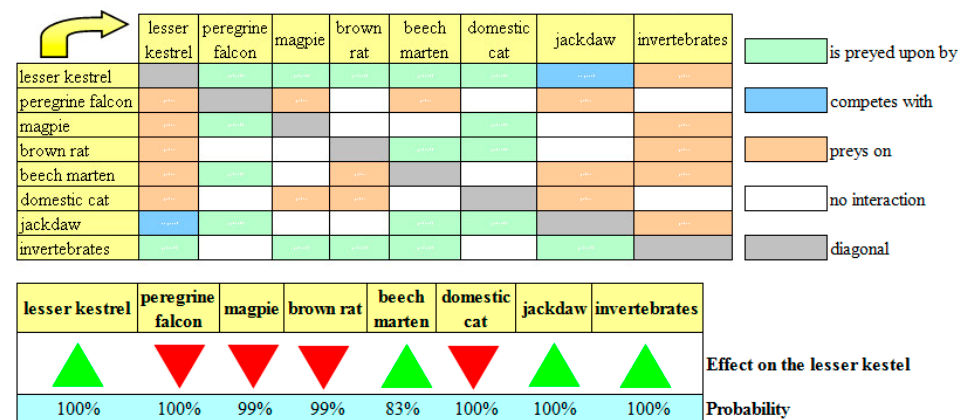
Figure 4. ( Top ) The community matrix of the lesser kestrel in the Alta Murgia for the “beech marten” scenario. The matrix must be read from the rows to the columns. ( Bottom ) Table of predictions. Key to reading: an increase in the growth rate of the jackdaw will result in an increase in the lesser kestrel population stock, with 100% probability. Predictions are shown for positive inputs. In the case of negative inputs (e.g., a decrease in the growth rate of the jackdaw), the predicted effects on the lesser kestrel population stock must be inverted, but the probabilities remain unchanged.